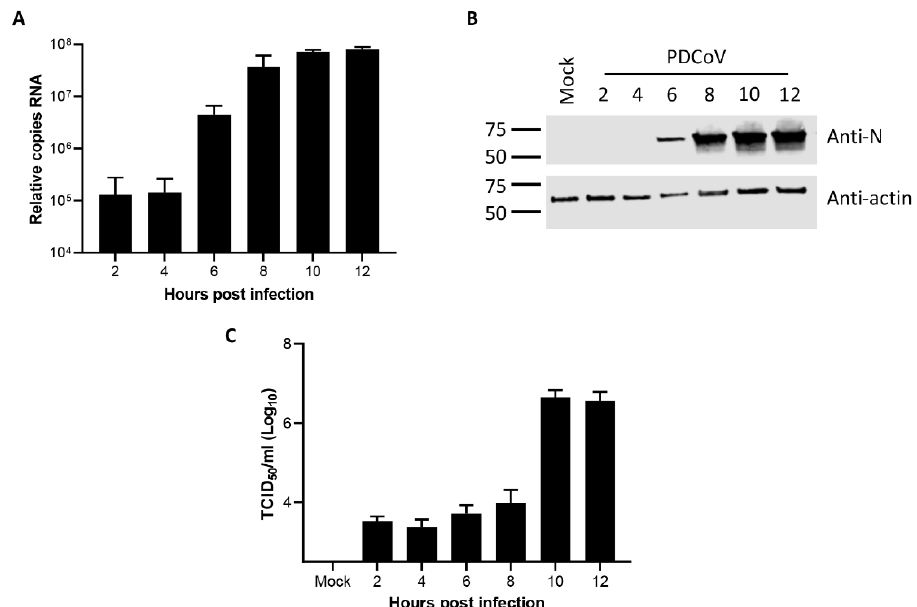
Figure 1. Dynamics of porcine deltacoronavirus (PDCoV) OH-FD22 replication in LLC-PK1 cells. ( A ) LLC-PK1 cells were infected with PDCoV and at the indicated timepoints, RNA was harvested and reverse transcribed to cDNA. The copy number of cDNA was quantified by quantitative polymerase chain reaction (qPCR) using a standard curve and normalized to mock-infected cells. Mean and standard deviation of three independent replicates are shown. ( B ) LLC-PK1 cells were PDCoV-infected or mock-infected. Total cell lysate was harvested at the stated timepoints and viral nucleoprotein detected (Anti-N) by western blot. Actin (Anti-actin) was used as a loading control. Molecular weight markers are shown. Blot representative of three independent repeats. ( C ) LLC-PK1 cells were infected with PDCoV and at the indicated timepoints and cell culture media was harvested. The titer of progeny virus was determined by tissue culture infectious dose 50 (TCID 50 ). Mean and standard deviation from three independent replicates are shown.